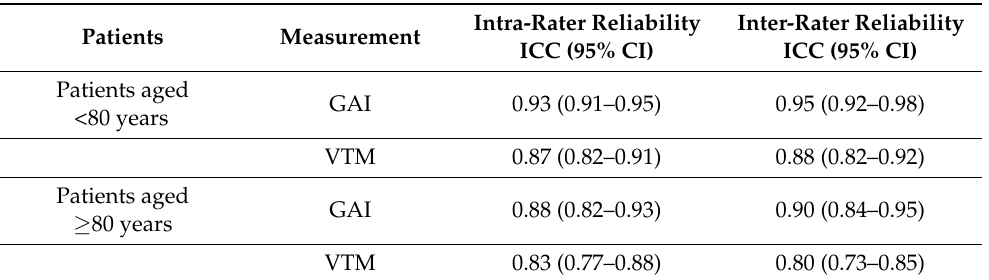
Table 3. Intra- and inter-rater reliability of the Garden alignment index and valgus tilt measurement for four raters in patients aged ≥ 80 years vs. aged <80